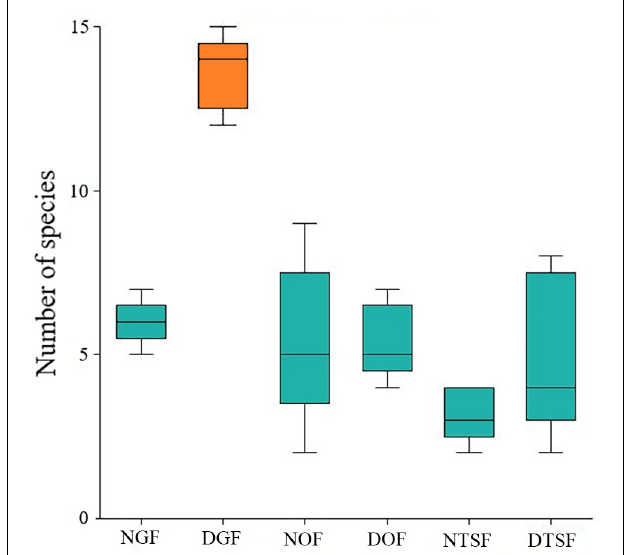
FIGURE 6 | Variation in number of epiphytic angiosperm species per sampling site (NGF = natural gallery forest, DGF = disturbed gallery forest, NOF = natural oak forest, DOF = disturbed oak forest, NTSF = natural tropical sub-deciduous forest, DTSF = disturbed tropical sub-deciduous forest). Green: no significant difference; Orange: with a significant